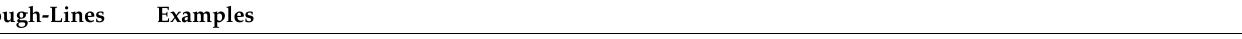
Table 4. Through-lines and Exemplar